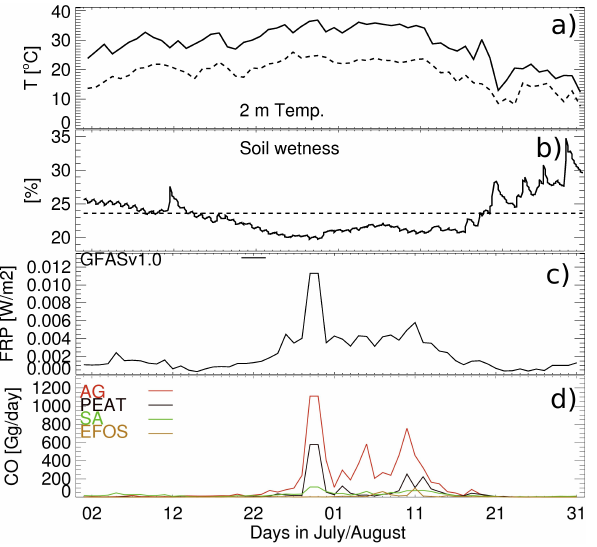
Fig. 2. Time series of (a) 2 meter daily maximum (solid) and min- imum (dashed) temperature, and (b) soil wetness at a location east of Moscow (42 ◦ E, 55 ◦ N) from ERA-Interim meteorology. The dashed line indicates the critical soil wetness level below which wa- ter stress is assumed to take place. Also shown are the c) GFASv1.0 FRP product averaged over western Russia, and (d) GFASv1.0 CO emissions over western Russia aggregated per fuel type. Only emis- sions from the four dominant fuel types are shown: AG: Agriculture, PEAT: Peat soils (histosols), SA: Savanna, EFOS: Extratropical for- est (with partial burning of organic soil matter).